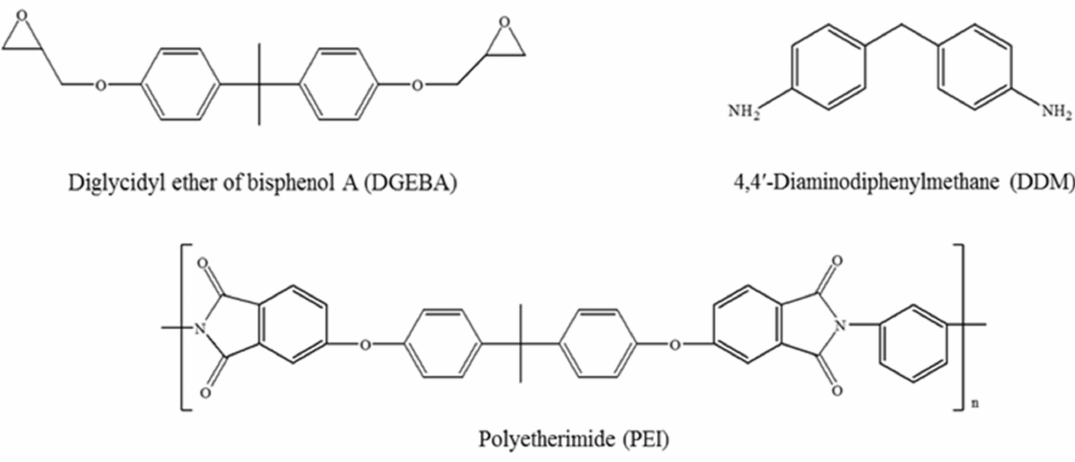
Figure 1. Chemical structures of DGEBA, PEI, and DDM.